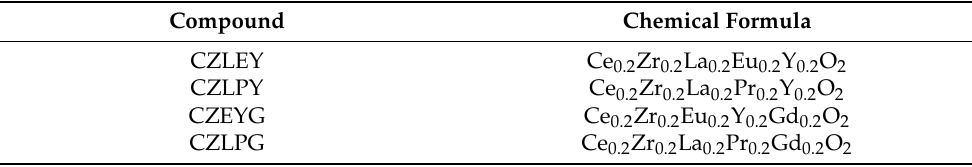
Table 1. Synthesized HEOs with their corresponding chemical